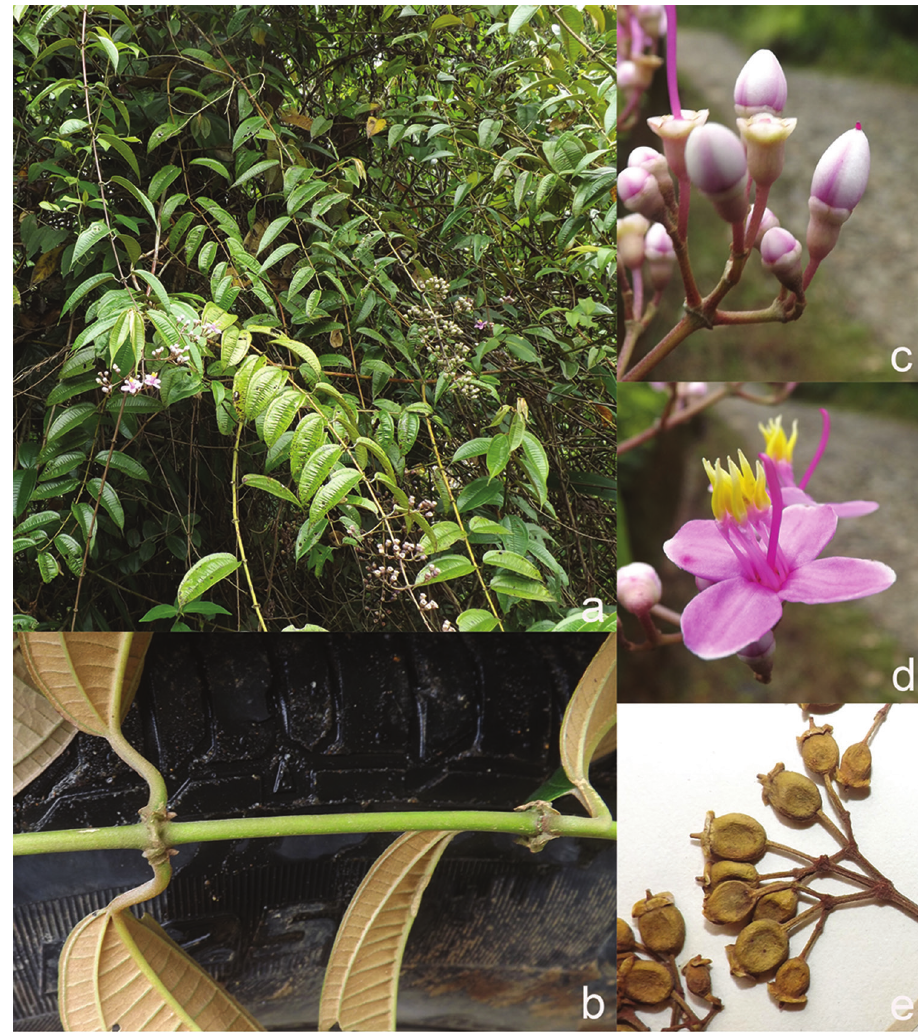
Figure 6. Dissochaeta bakhuizenii . a habit b branchlet c hypanthium d flower e fruits. Photographs by A. Kartonegoro; vouchers: Kartonegoro 1103 (BO, L). tubular, 2–5 × 1–3 mm, sparsely stellate-puberulous or nearly glabrous, somewhat 8-ridged; calyx truncate with 4 undulate lobes, widened, ca. 1 mm long, glabrous; petal bud conical, 3–5 × 2–3 mm; mature petals ovate, 4–5 × ca. 4 mm, base clawed, apex rounded, glabrous with ciliate margin, pale pink to violet. Stamens 8, equal or subequal, filaments straight; alternipetalous stamens with 4–6 mm long filaments, anthers oblong or lanceolate, straight, thecae 4–5 mm long, yellow, pedoconnective ca. 0.5 mm long, basal crests triangular with a small pair of acute auricles, 1.5–2 mm long, lateral appendages absent or prolonged from basal crest, 1–2 mm